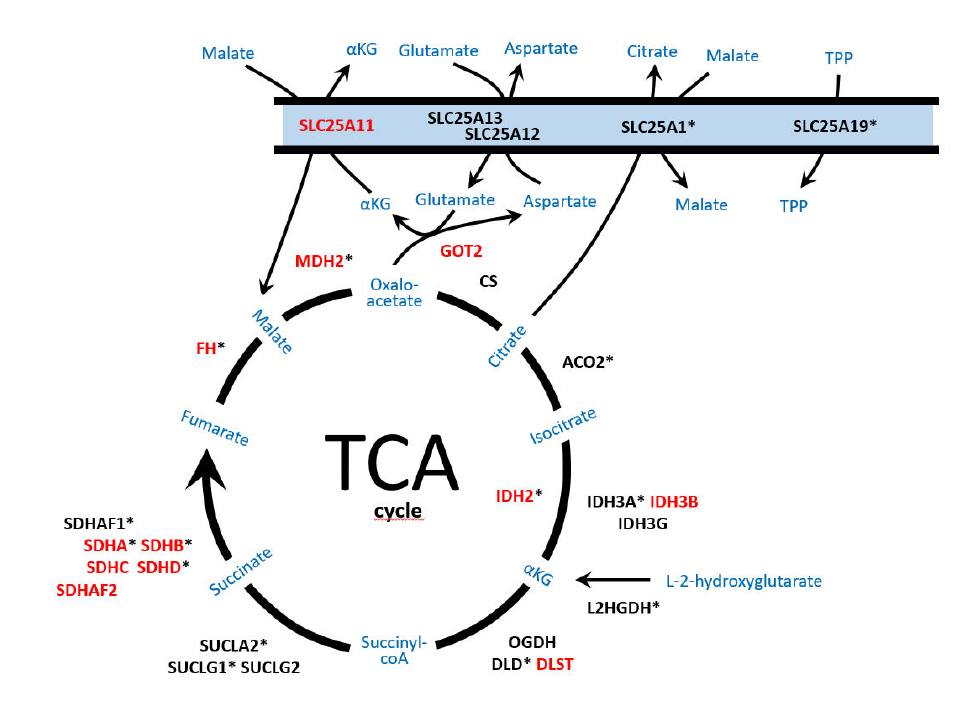
Figure 1. Schematic representation of the enzymes and mitochondrial metabolic pathways, tricarboxylic acid (TCA) cycle, malate / aspartate shuttle, nicotinamide adenine dinucleotide (NADH) exchange and metabolite e ffl ux from the mitochondria, involved in pheochromocytoma and paraganglioma (PPGL) development and / or neurodegenerative disorders. Enzymes reported as altered in PPGL are denoted in red capital letters. Enzymes involved in neurodegenerative disorders are denoted with an asterisk. SLC25A11: solute carrier family 25 member 11; SLC25A12 / SLC25A13: carriers solute carrier family 25 members 12 / 13; SLC25A1: solute carrier family 25 member 1; SLC25A19: solute carrier family 25 member 19; GOT2: mitochondrial glutamic-oxaloacetic transaminase 2; FH: fumarate hydratase; MDH2: mitochondrial malate dehydrogenase; CS: citrate synthase; ACO2: mitochondrial aconitase; IDH2: isocitrate dehydrogenase 2; IDH3A / IDH3B / IDH3G: subunits of isocitrate dehydrogenase 3; L2HGDH: L-2-hydroxyglutarate dehydrogenase; OGDH / DLD / DLST: subunits of the α KG (alpha-ketoglutarate) dehydrogenase complex; SUCLA2 / SUCLG1 / SUCLG2: subunits of succinyl-CoA synthetase; SDHA / B / C / D: subunits of the succinate dehydrogenase complex; SDHAF1 / SDHAF2: succinate dehydrogenase assembly factors; α KG: α -ketoglutarate; TPP: thiamine